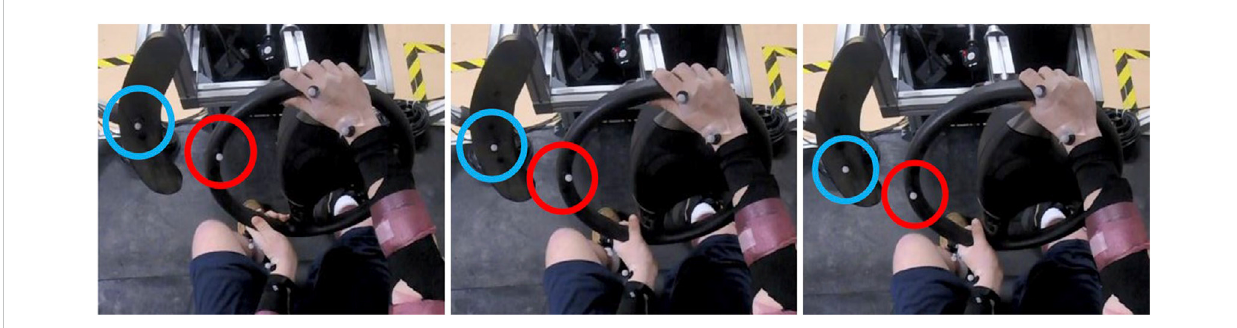
Example of alignment positions of the photo-re fl ective marker on the steering wheel (red)and photo-re fl ective marker on the lateral post (blue) for each of the three positions (left, center, right images).